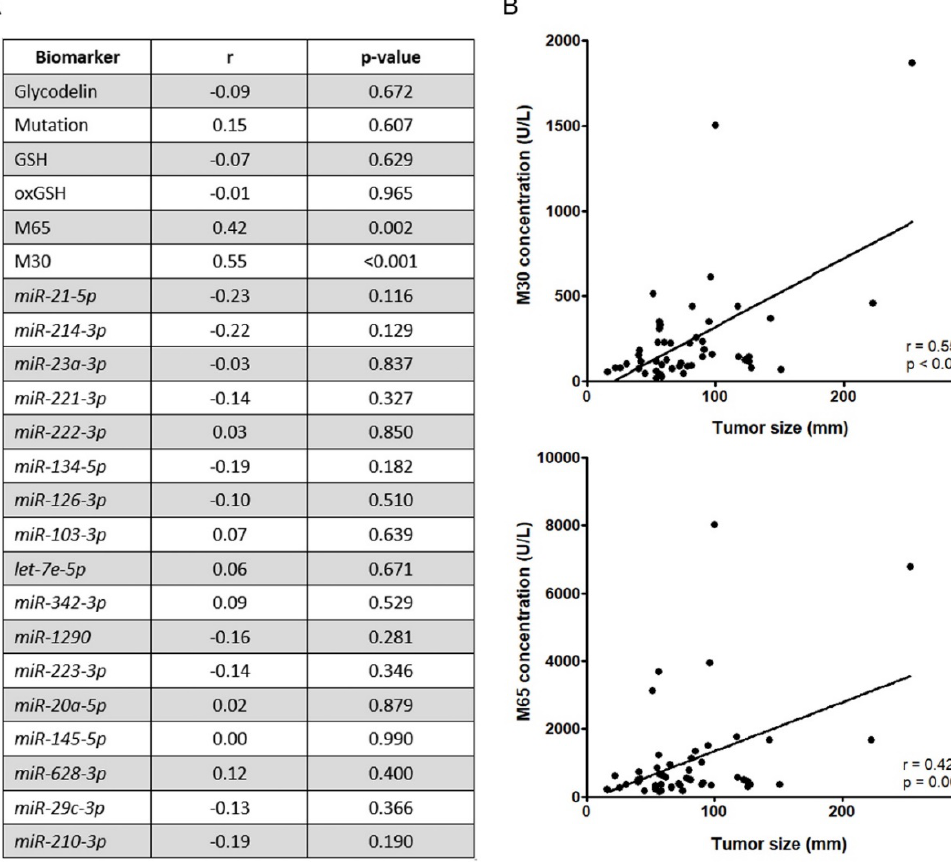
Figure 3. Correlation of markers and tumor load at baseline. ( A ) Linear regression analyses of the individual biomarkers and the tumor load at baseline time point. ( B ) Correlation plots of the two biomarkers with the highest correlation (M30 and M65).